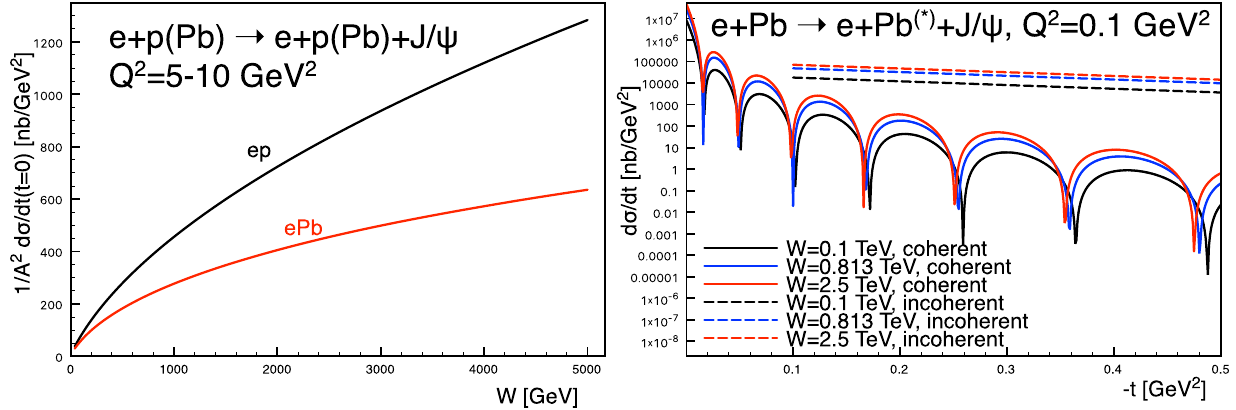
Fig. 16.12 Left: energy dependence of the cross section at t = 0 for coherent diffraction [444] for Q 2 = 5 ÷ 10 GeV 2 . Right: t -differential cross section for coherent and incoherent diffractive production of J / ψ in ePb for photoproduction at different energies